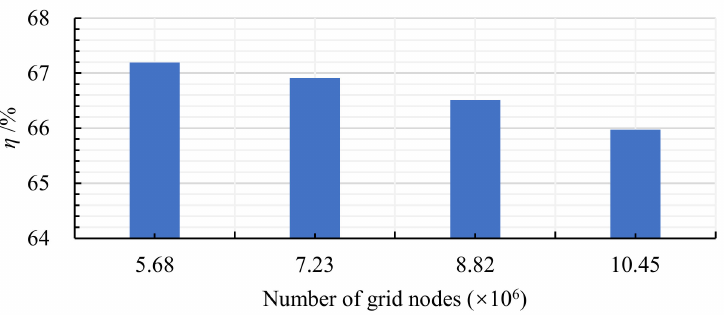
Figure 3. Grid independence of full tubular pump device with 2 mm backflow